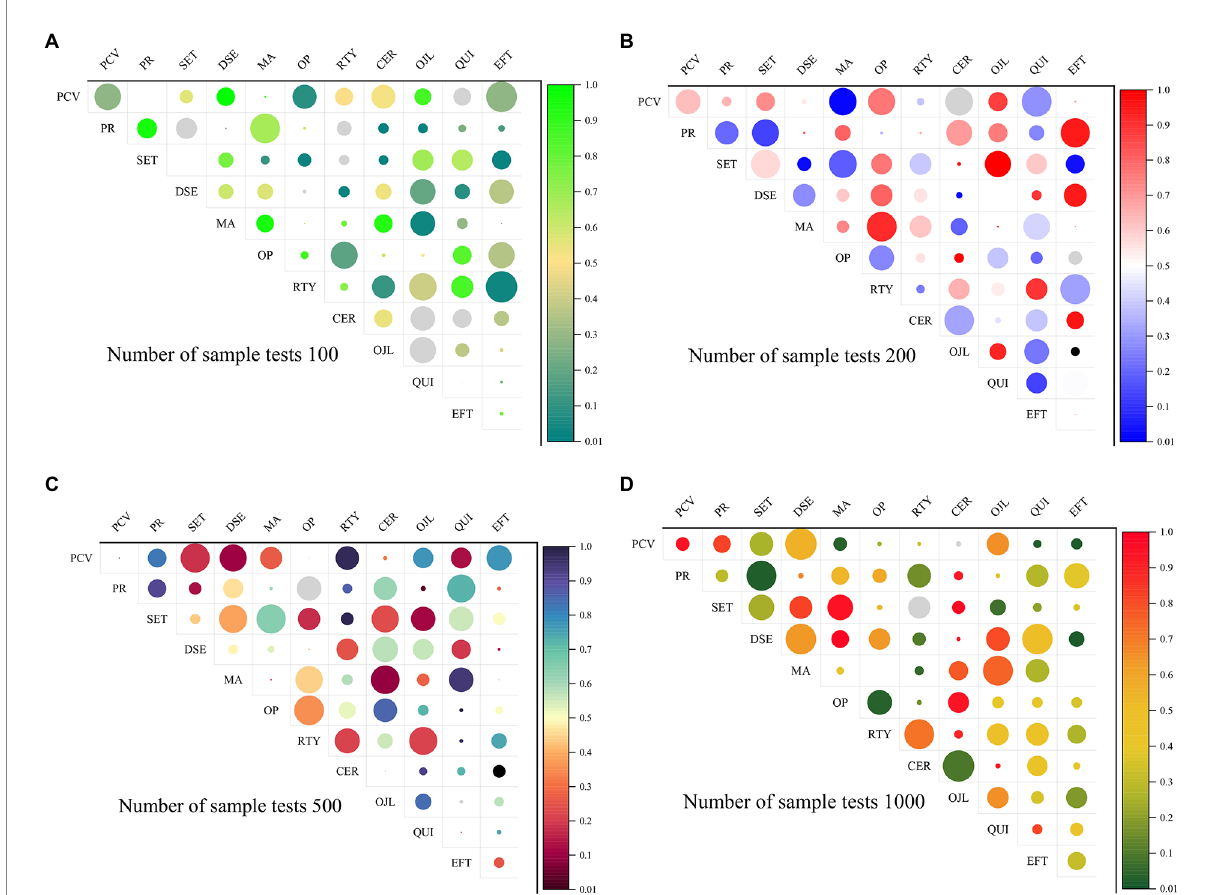
FIGURE 2 T-test results of each psychological index of the sample. (A) Number of sample tests 100. (B) Number of sample tests 200. (C) Number of sample tests 500. (D) Number of sample tests